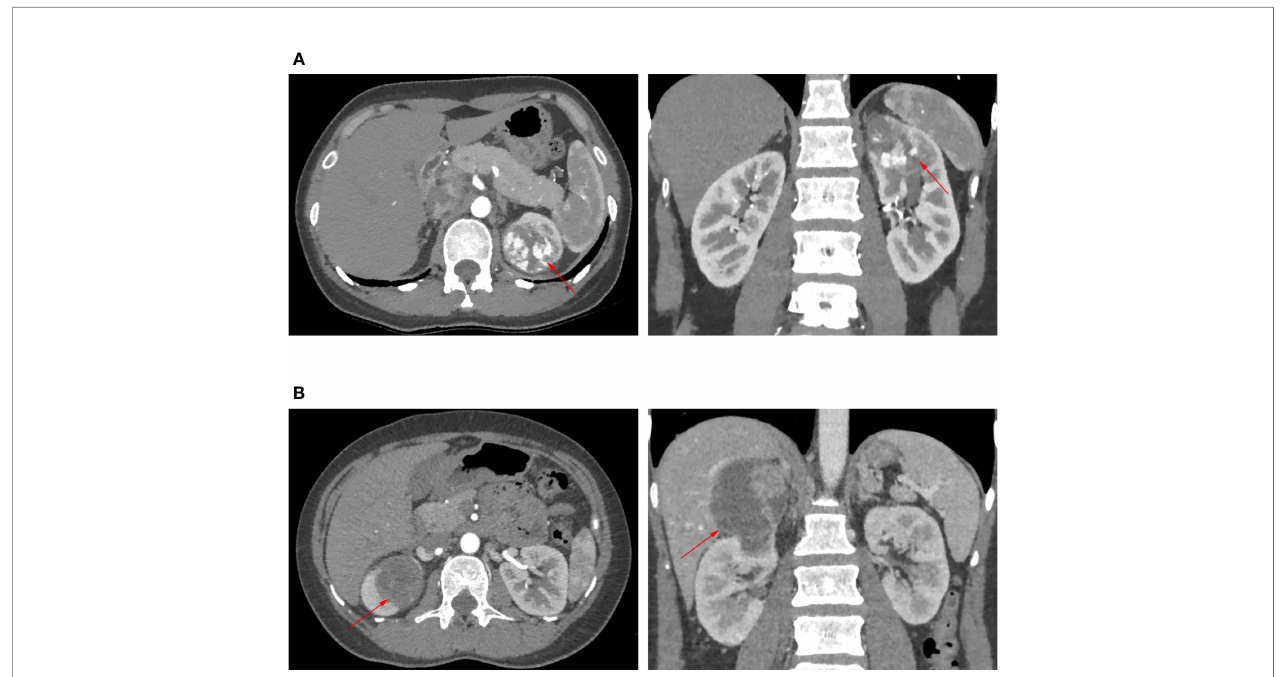
FIGURE 1 | Representative images of CT or MRI. Red arrow points to renal tumor. (A) The patient underwent transperitoneal robotic partial nephrectomy. (B) The patient underwent retroperitoneal robotic partial